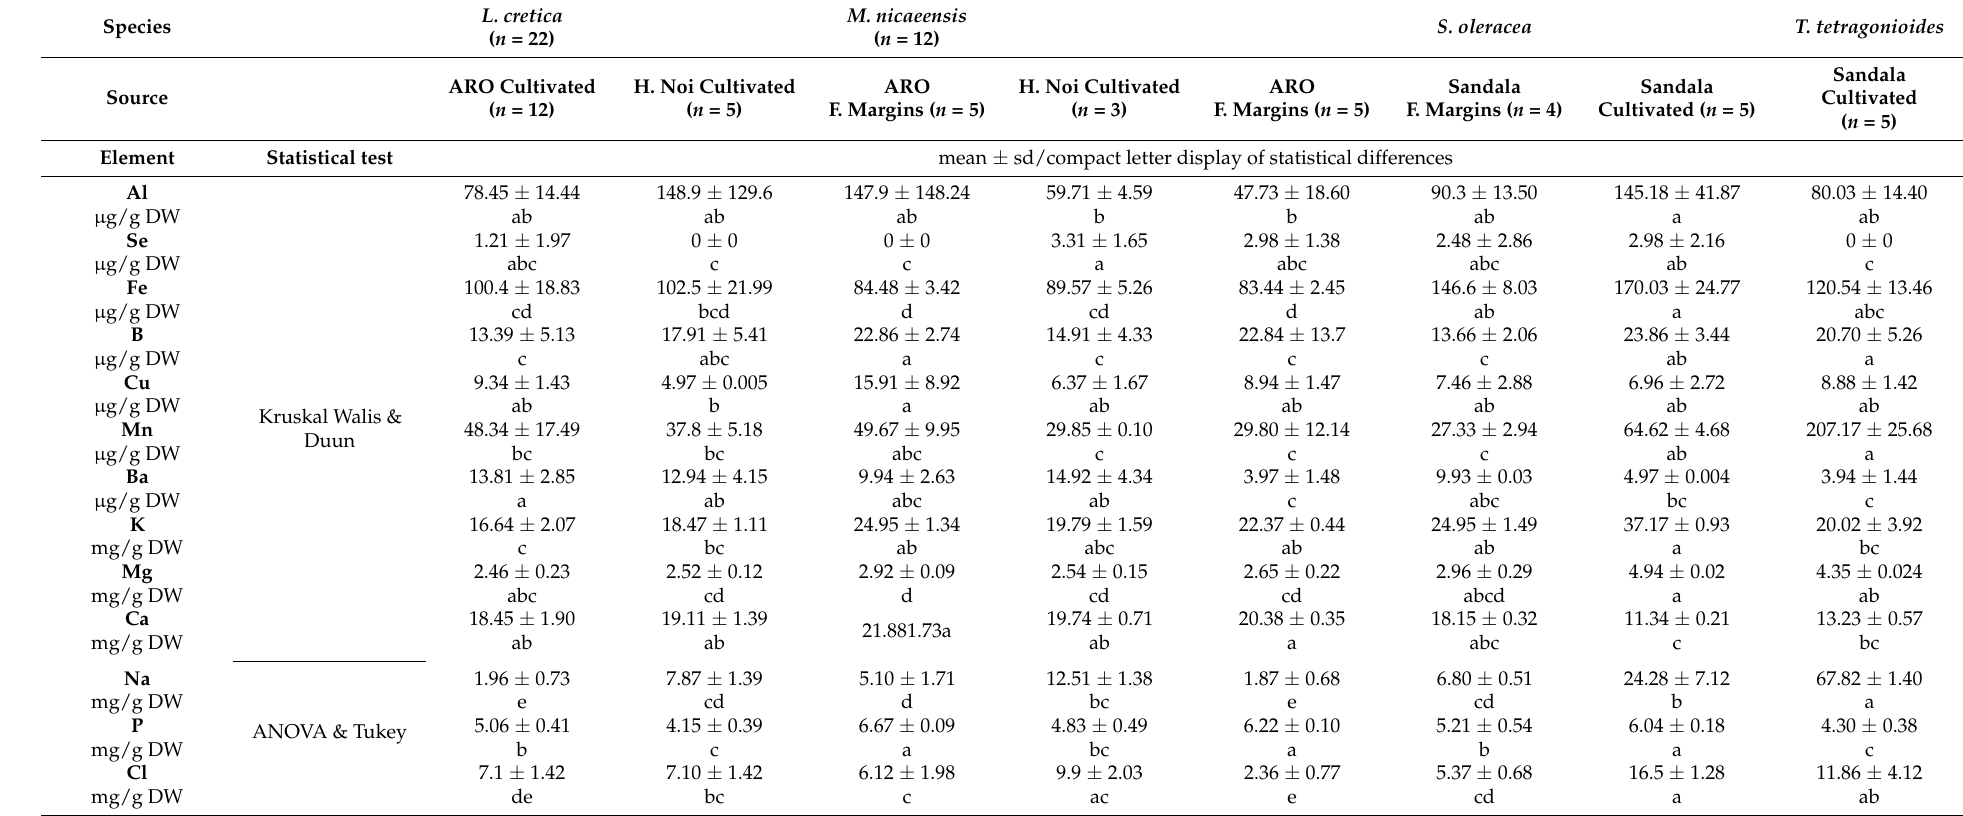
Table 1. Elemental analysis of macro- and micro-elements in two Malvaceae species and two spinach species. Value per each element is given in the first left column, and the statistical test that we performed at the second column to the left. Different lowercase letters indicate significant differences between populations of green leaves ( p < 0.05), comparing all populations per element. Number or samples for statistical replicates is given in parentheses ( n = X) for each population. Species names and abbreviation of locations are given in the headline. H. Noi stands for Havat Hanoi, and ARO for research station at the Agricultural Research Organization; Sandala = agricultural area near Sandala village, North Israel. Under the location name we indicate plant origin type—either “cultivated” in an agricultural field, or wildly grown at field (F.)